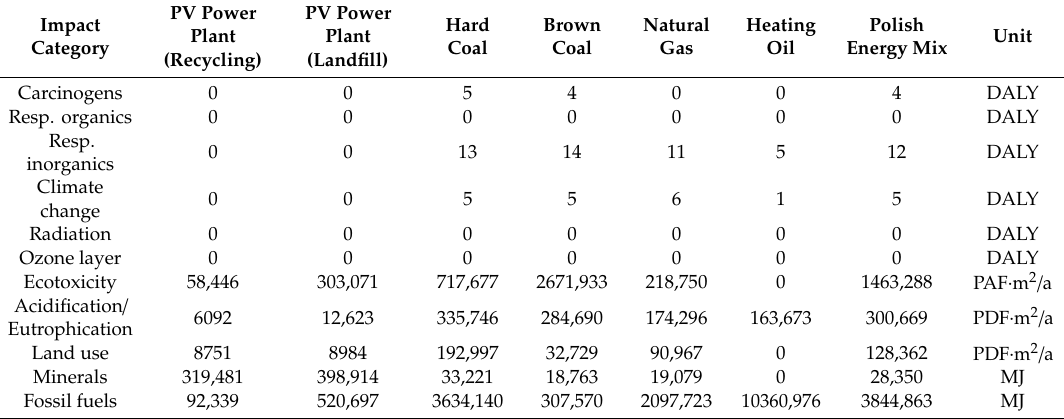
Table 15. Results of the characterization of environmental consequences arising as a result of the generation of 20,000 MWh of electricity from selected energy sources.